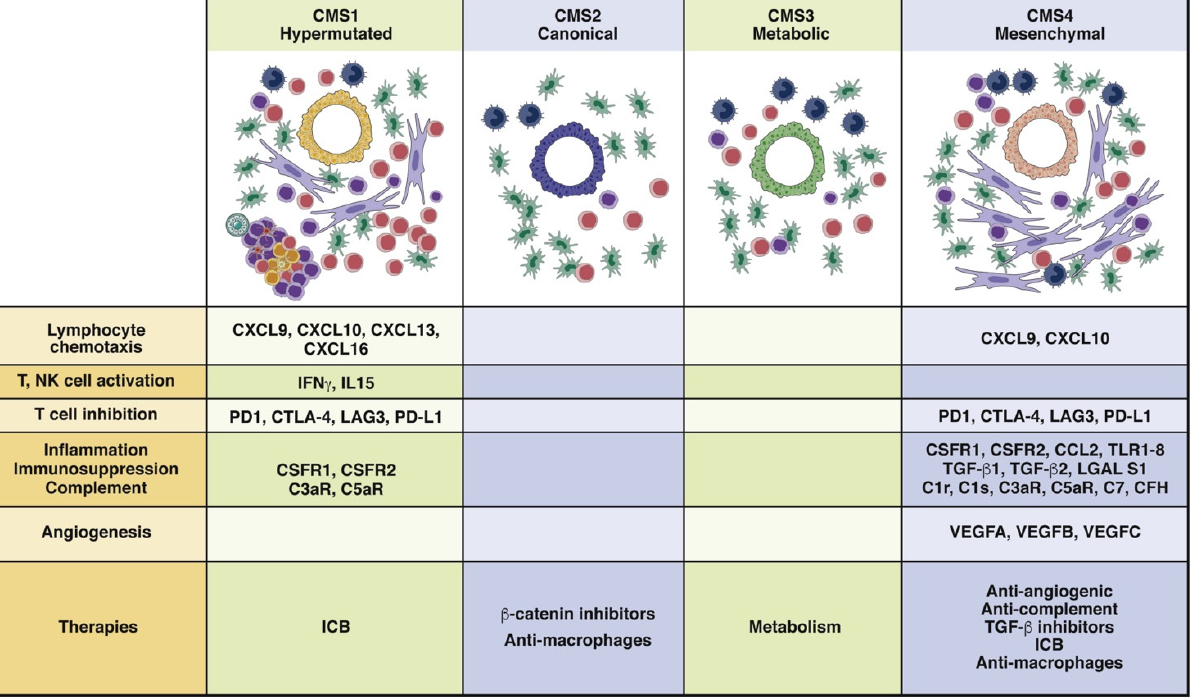
Figure 4. The consensus molecular subtypes. CMS1 and CMS4 tumors are highly infiltrated by immune cells, whereas CMS1 tumors are characterized by a Th1-cell response and activated and inflamed TME. These tumors can be treated with immune checkpoint inhibitors. CMS4 tumors have an inflamed, complement-rich, suppressive, and highly angiogenic TME that can be targeted with combination therapies. CMS2 tumors do not activate an antitumor immune response due to activation of the b-catenin pathway, and CMS3 tumors are considered to be metabolic tumors. CMS1 (14% of colorectal tumors); CMS2 (37% of colorectal tumors); CMS3 tumors (13% of colorectal tumors); CMS4 tumors (23% of colorectal tumors). From Fridman et al. [9].